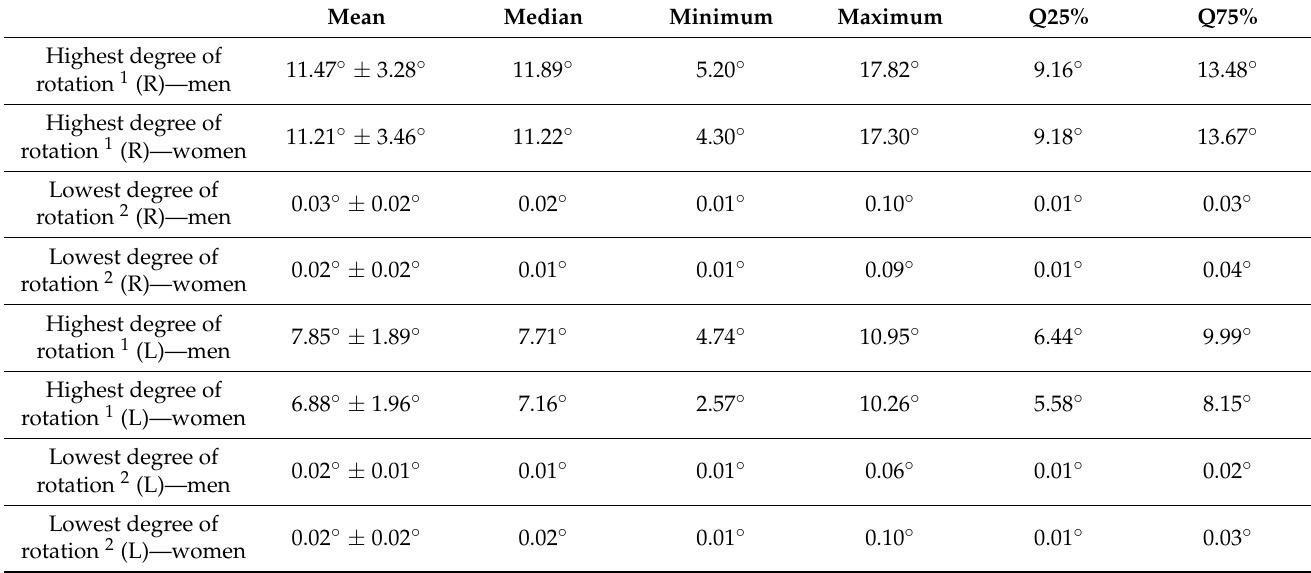
Table 5. The highest and lowest degree of lumbar spine (L1–L5) rotation in men (n = 30) and women (n =